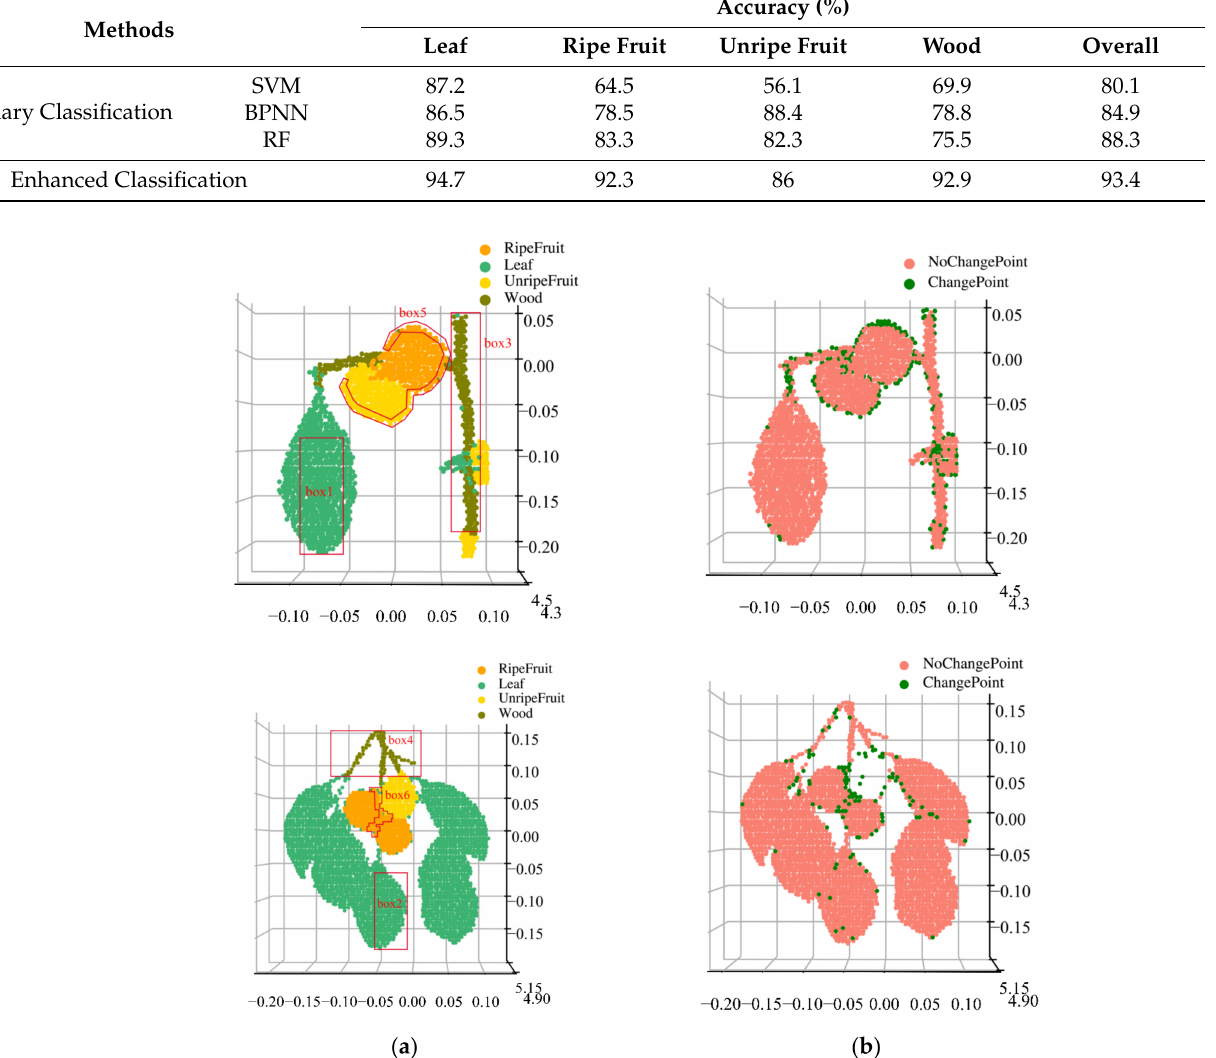
Figure 9. Reconstruction of classification results and changes in point cloud class. ( a ) Reconstruction based on the proposed method and ( b ) class changes in the reprogramming strategy. The red boxes are the areas misclassified in the preliminary